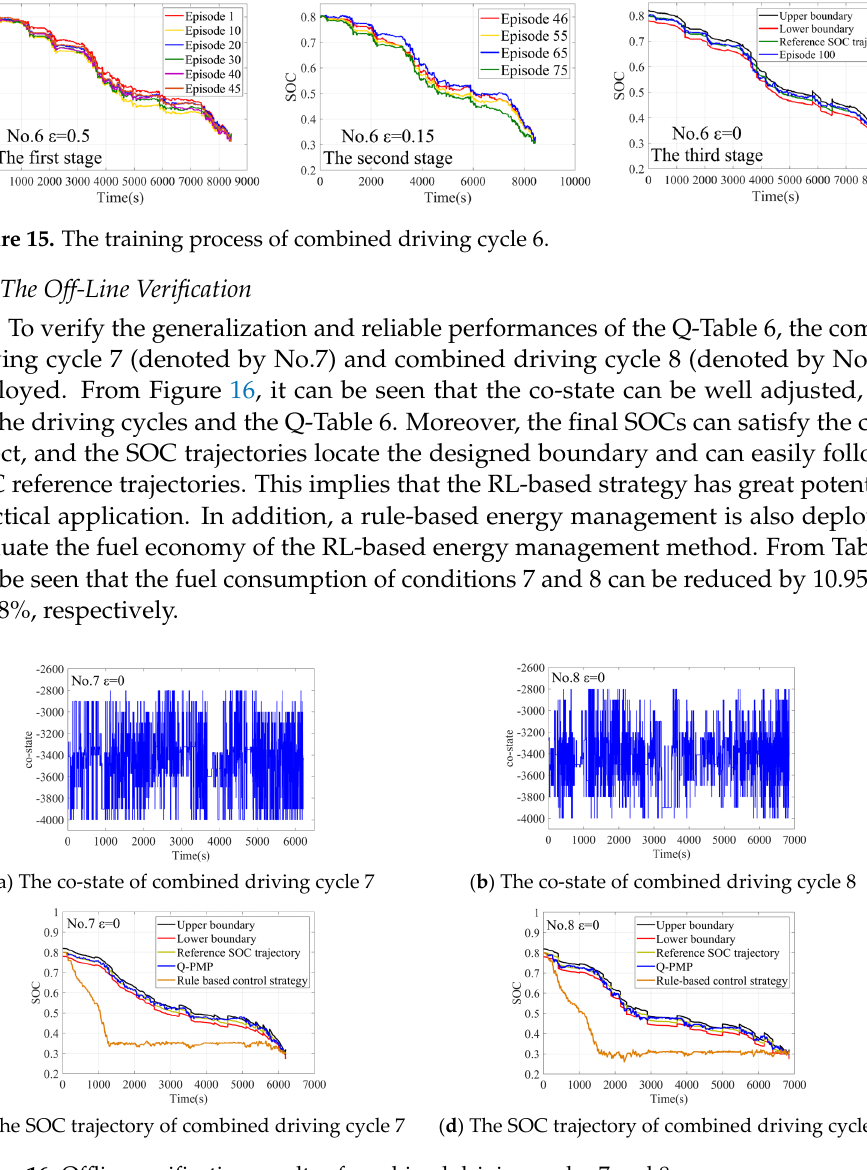
Figure 16. Offline verification results of combined driving cycles 7 and 8.